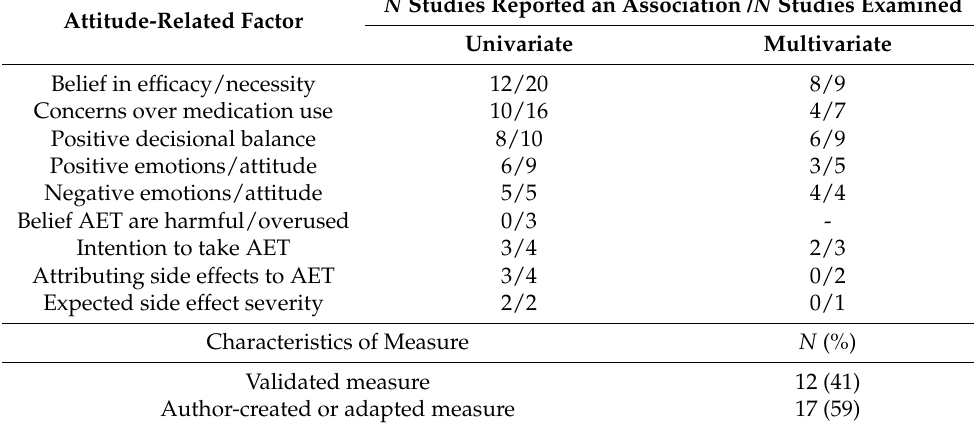
Table 4. Characteristics of studies that measured attitudes toward AET ( N =